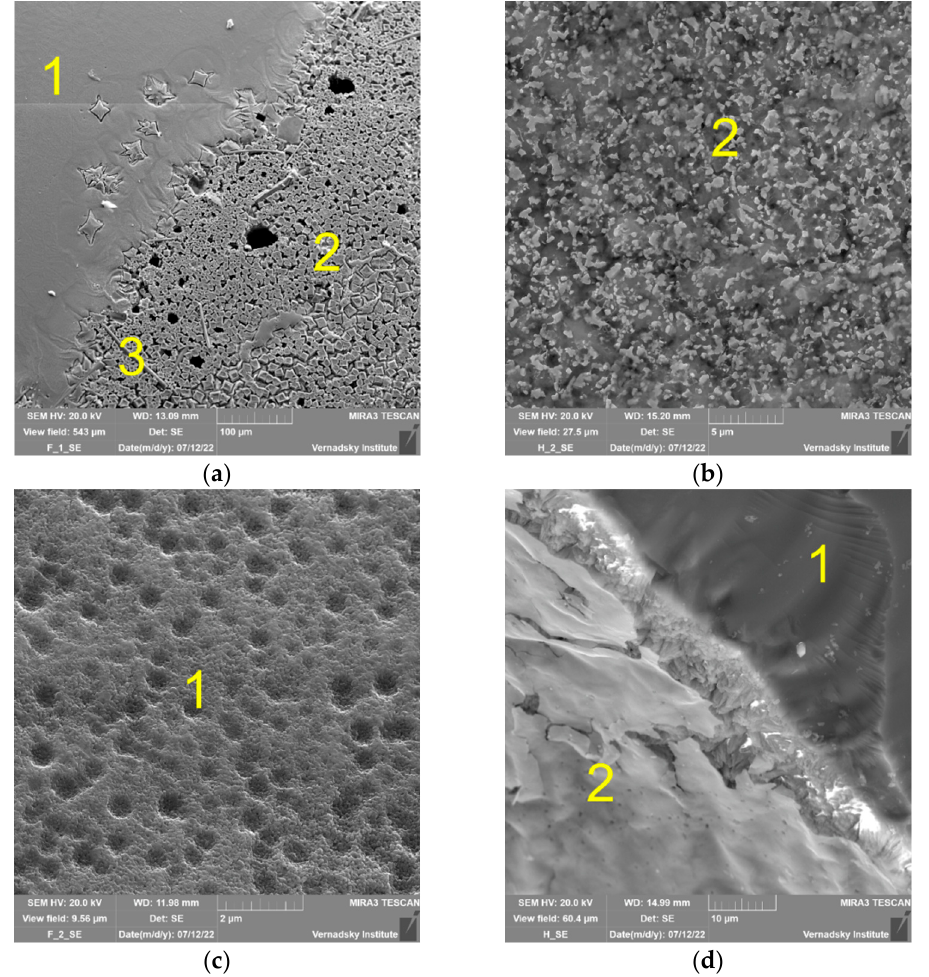
Figure 5. SEM images of NAFP glass after leaching in a 7.0 wt.% H 2 O 2 solution: ( a , b ) the surface of the initial sample; ( c ) the surface of the sample after heat treatment at 450 °C; ( d ) the surface layer boundary of the heat-treated glass. Table 3. The semiquantitative elemental composition (wt.%) of samples of NAFP glass after contact with a 7.0 wt.% H 2 O 2 solution.